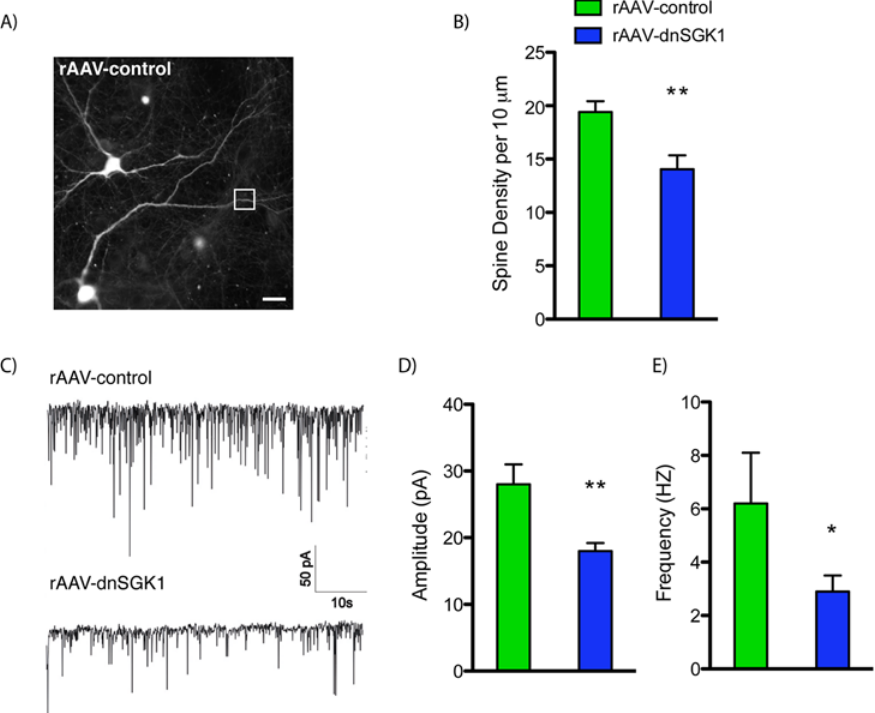
Fig 6. Impact of dnSGK1 overexpression on dendritic spine density and electrophysiological properties in cultured neurons. Primary neuronal cultures were incubated with rAAV-control or rAAV- dnSGK1, and spine density and function were analyzed (14 – 16 DIV). (A) Representative image of EGFP labeling in primary neurons exposed to control virus. Scale bar = 25 μ m. (B) Quantitation of spines density showing a decrease in neurons cultured with dnSGK1 (neurons, n = 6; branches, n = 7; total dendritic length = 174.36 μ m) as compared to EGFP control (neurons, n = 5; branches, n = 7; total dendritic length = 197.95 μ m). Data are shown as mean ± SEM, compared to the control group (t(12) = 3.24, Student ’ s t test, ** p < 0.01]. (C) Analysis of spontaneous mEPSCs (representative recording traces) in hippocampal primary neurons (16 DIV) overexpressing dnSGK1 ( n = 7) showed a decrease in amplitude (D) and frequency (E) of mEPSCs compared to EGFP controls ( n = 6). Data are shown as mean ± SEM, compared to the control group (t(11) = 4.335, ** p < 0.01 for the amplitude; t(11) = 2.738, * p < 0.05 for the frequency, Student ’ s t test). For underlying data, see S1